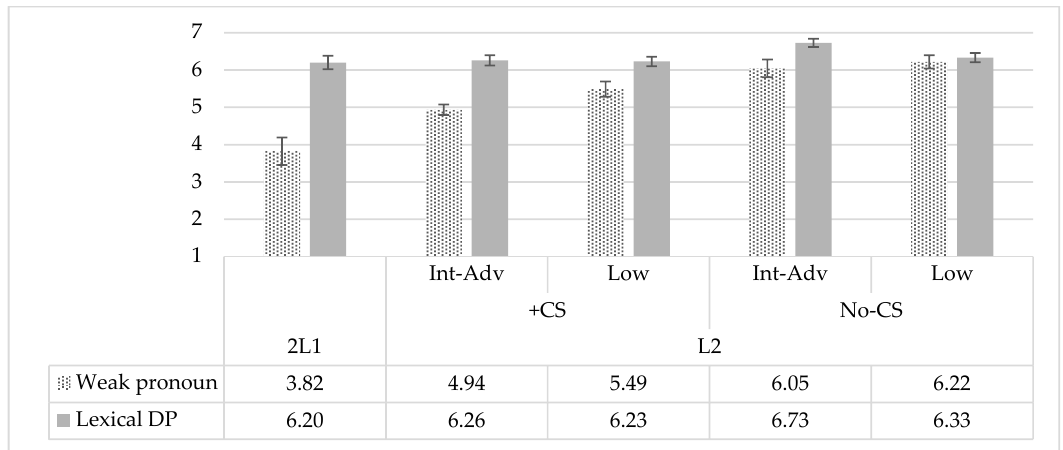
Figure 10. Code-switched Spanish-to-English subject stimuli ratings by group and type.